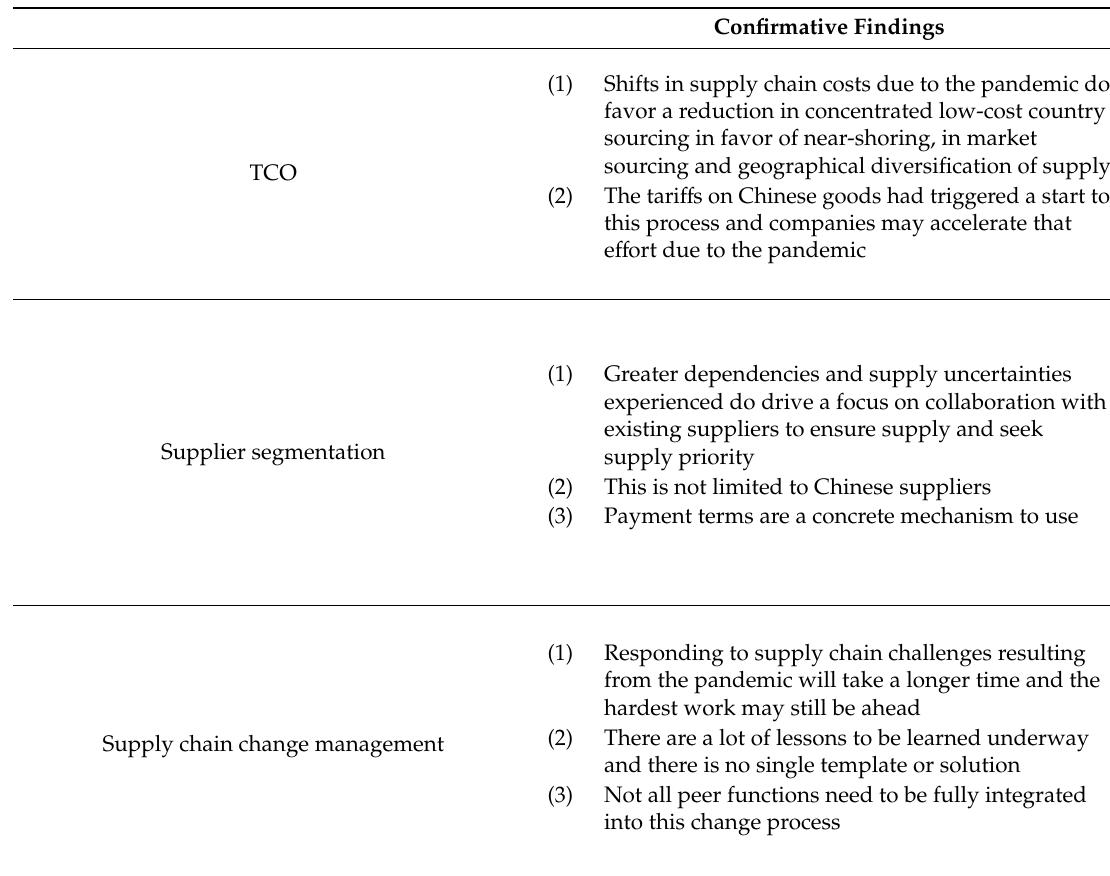
Table 7. Interpretation of findings by